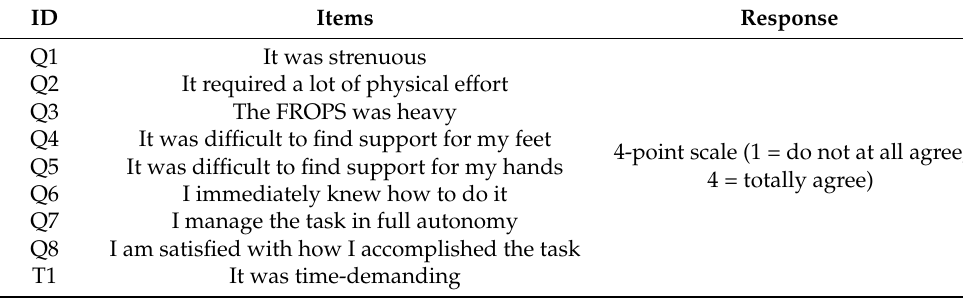
Table 1. Questions used to evaluate the usability during the FROPS